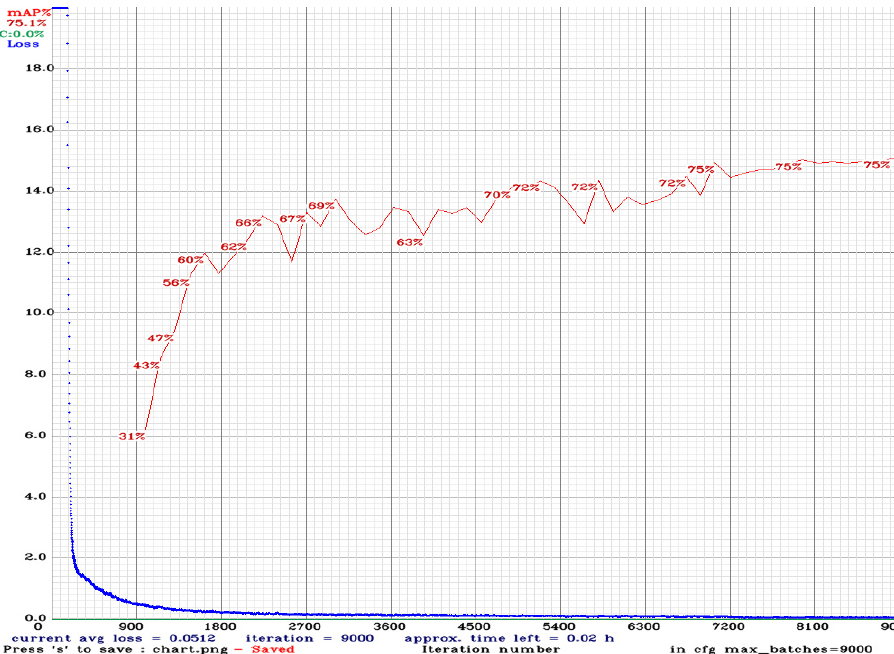
Figure 14. Loss and accuracy graph of the YOLOv4 ‐ Tiny.